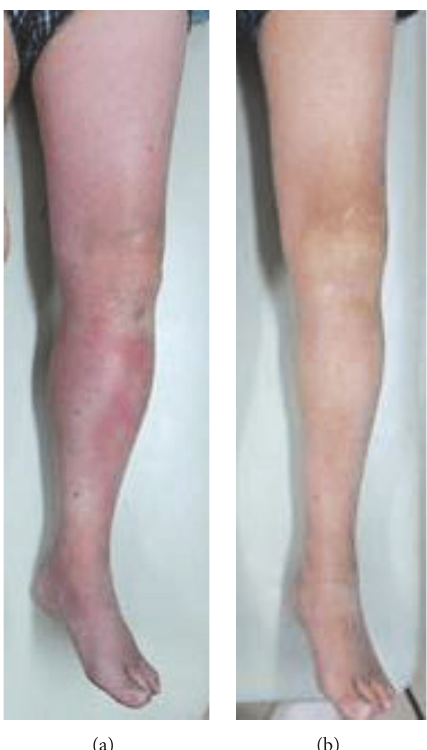
Figure 3: (a) Preoperative photograph showing left leg swelling and redness. (b) Photograph taken 3 weeks after revision surgery showing almost complete resolution of inflammatory changes in the left